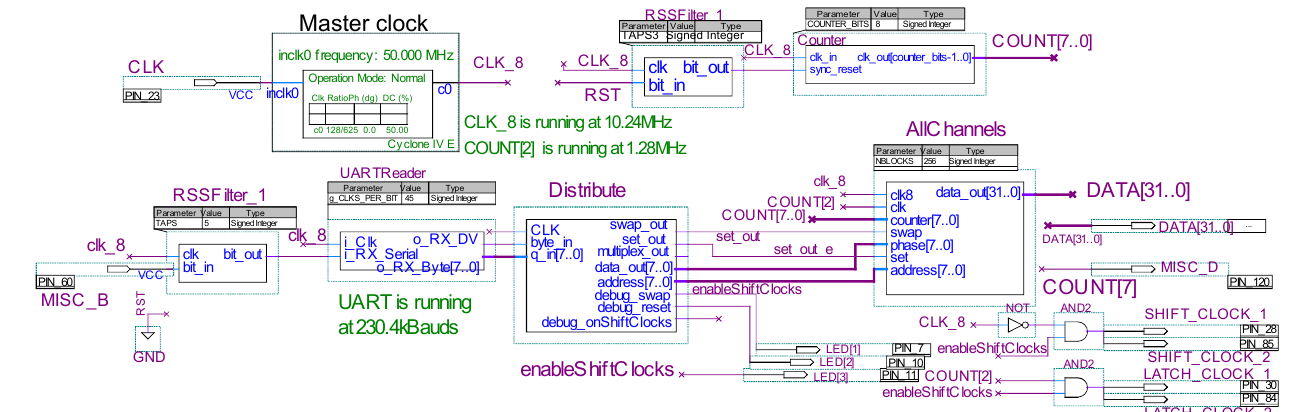
Figure 5. Block diagram of the code that is synthesized in the FPGA. On the top-left, the MasterClock is a phase-locked loop (PLL) to transform the internal 50 MHz clock into a 10.24 MHz clock named CLK_8. At the top-right, there is a global counter that acts as a frequency divider of CLK_8: COUNT[7] sets at 40 kHz and is output as the reference signal on MISC_D; COUNT[2] is the latch clock. If the board acts as a slave, the counter is synchronized with a 40 kHz external signal filtered by a RSS filter. On the bottom left, the UART input is filtered, read, and sent to the distributor. The distributor updates the emission phases of the generator blocks. AllChannels contain 256 generator blocks that connect to 32 Multiplexers of eight channels each. The generator blocks and multiplexers are timed by the outputs of the global counter. At the bottom-right, the multiplexed data channels as well as the latch and shift clocks are